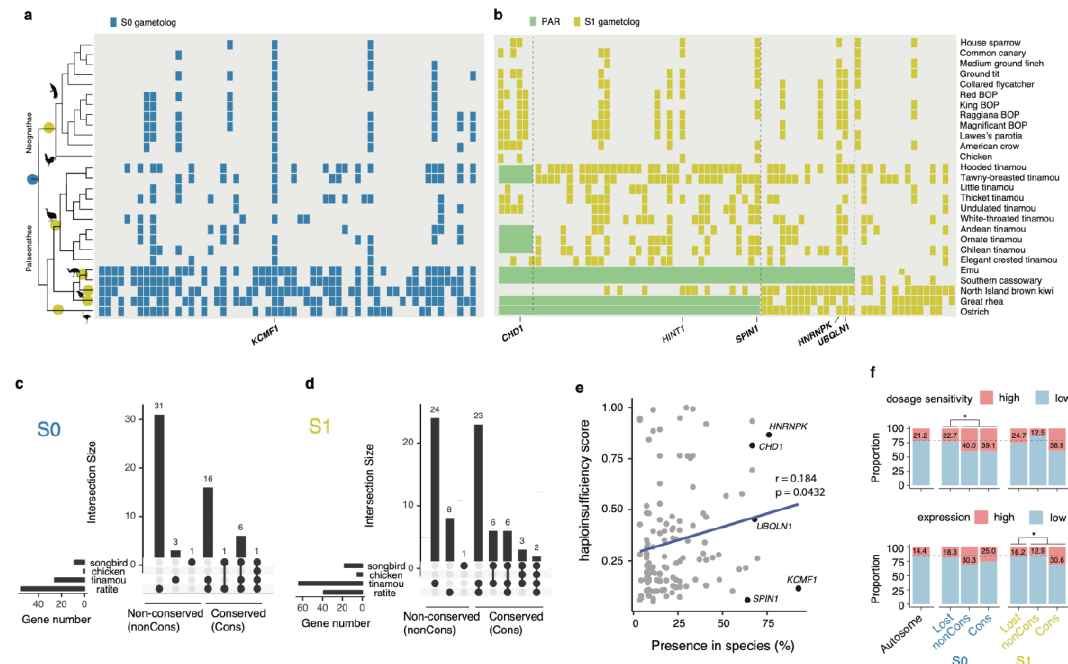
Figure 3. Conservation of W chromosome gene content maintained by purifying selection. ( a , b ) The colored circles on the phylogenetic branches indicate the origins of S0 (blue) and S1 (yellow). Each tile represents a W-linked gametolog. The genes are ordered according to their homologous positions on the emu Z chromosome. Five conserved boundary genes and HINT1 are highlighted. ( c , d ) The UpSet plots show the numbers of shared W-linked gametologs across three groups of songbirds, chicken, tinamous, and ratites. When one gene was shared by at least two groups of birds, it was defined as conserved. ( e ) The X -axis represents the percentage of species where the W-linked genes are present. It is positively correlated with the gene’s predicted haploinsu ffi ciency score of human ortholog (Pearson’s correlation coe ffi cient and the p -value are shown). Black dots represent the five conserved genes at the strata boundaries. ( f ) Genes were defined as having high dosage sensitivity and high expression level when the predicted haploinsu ffi ciency scores are larger than 0.4 and expression level (TPM) are larger than 50, respectively. The dotted line shows the average levels of autosomes. The asterisks represent significant results ( p -value < 0.05) of Fisher’s exact